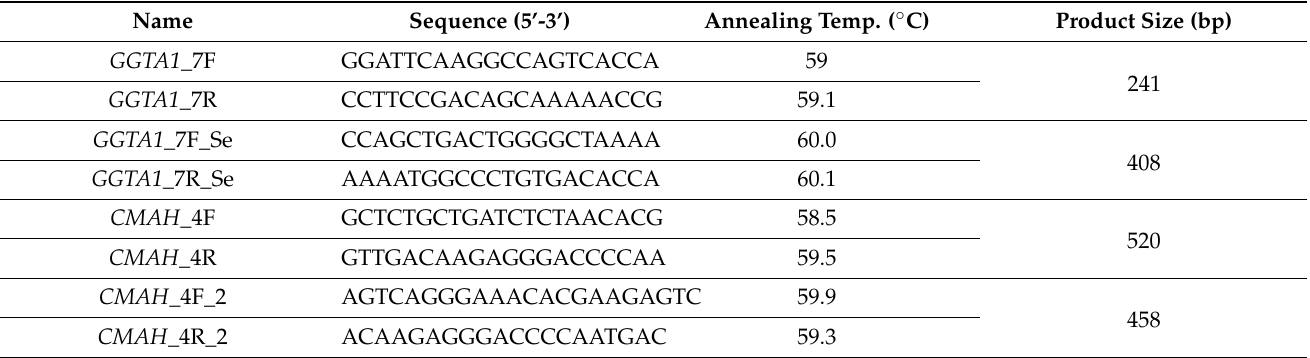
Table 2. List of primers used for PCR and